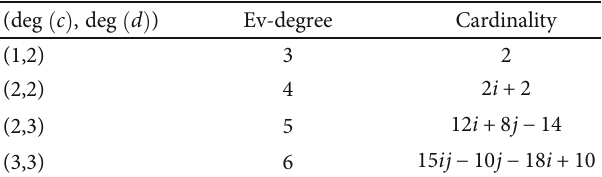
Table 5: Ev-degree of SiC